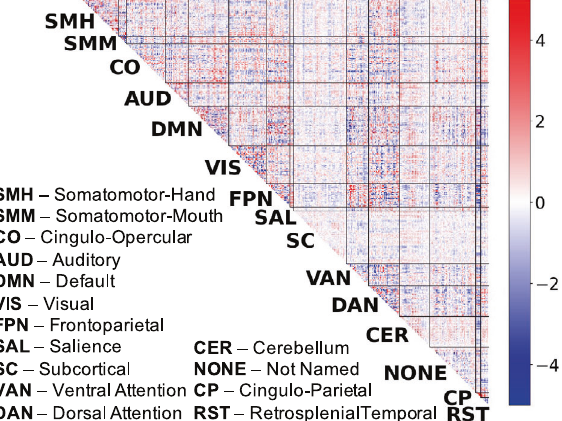
Fig. 3 Brain connectivity patterns are predictive of GCA. We found that multivariate predictive models trained on brain functional connectivity maps were effective in predicting GCA in held-out subjects. We created a consensus map that summarizes functional connectivity patterns that contribute to effective GCA prediction.